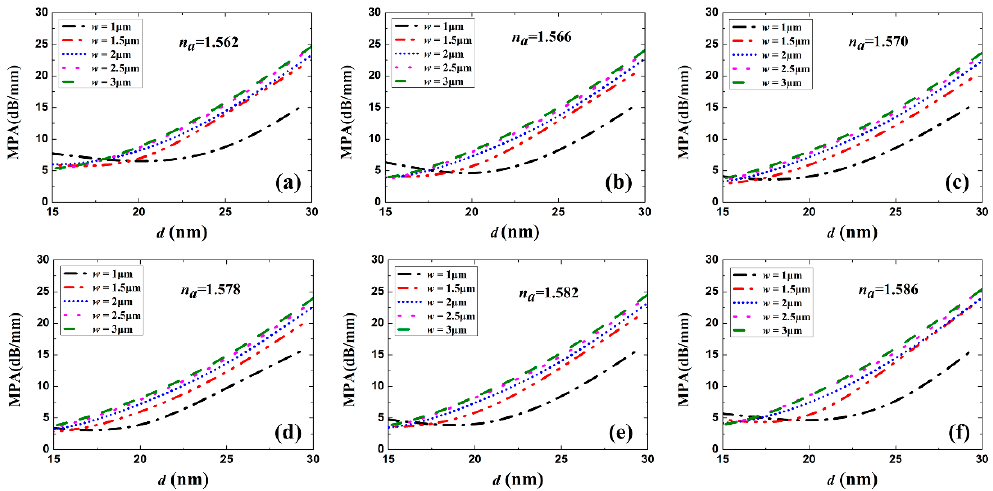
Figure 5. Coupling loss between cladded waveguide and sensing section as a function of Au stripe thickness d for different stripe widths w and sensing solutions with n a of ( a ) 1.562, ( b ) 1.566, ( c ) 1.570, ( d ) 1.578, ( e ) 1.582 and ( f ) 1.586.